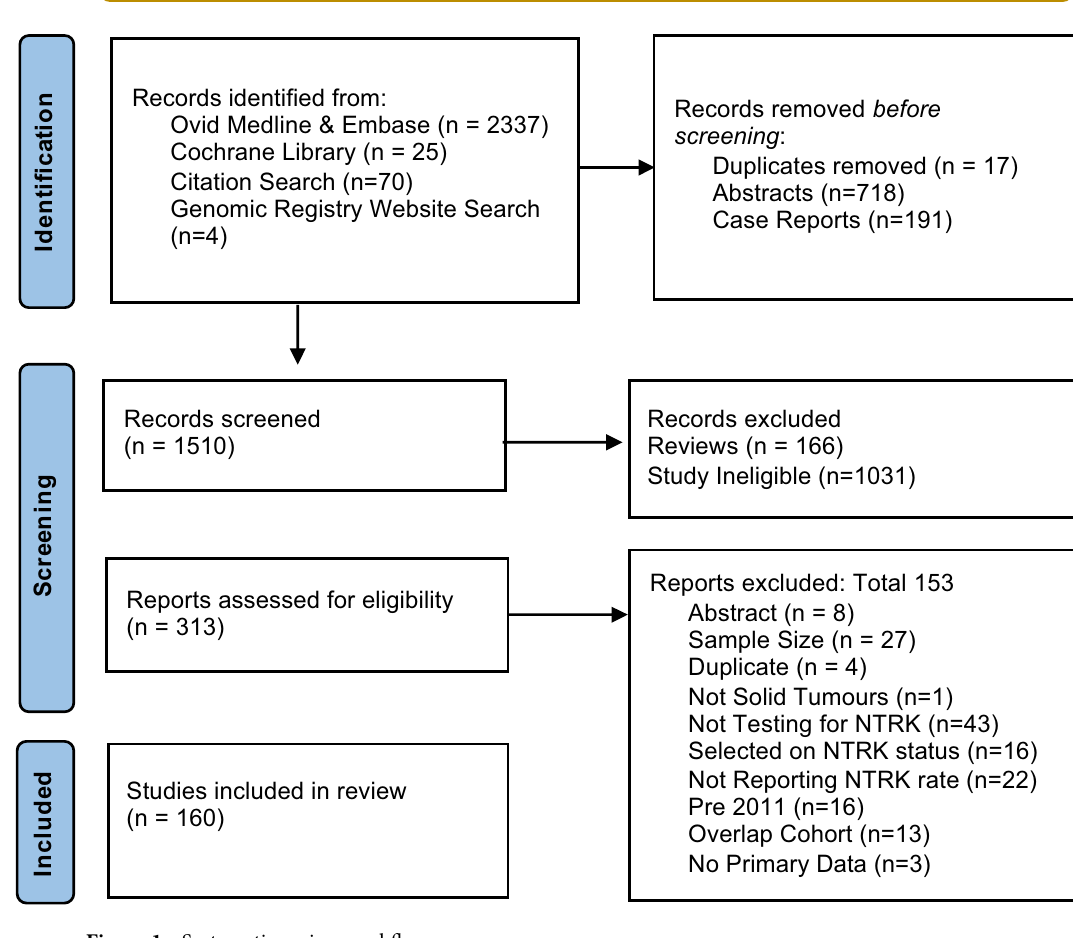
Figure 1. Systematic review